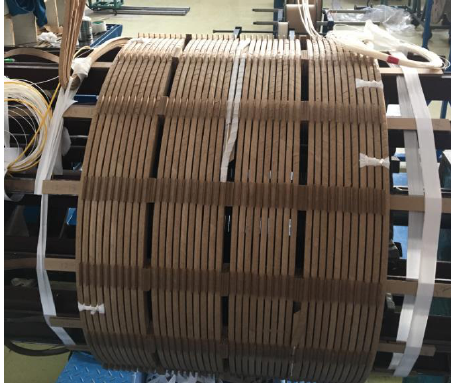
Figure 4. Winding with build-in fiber.